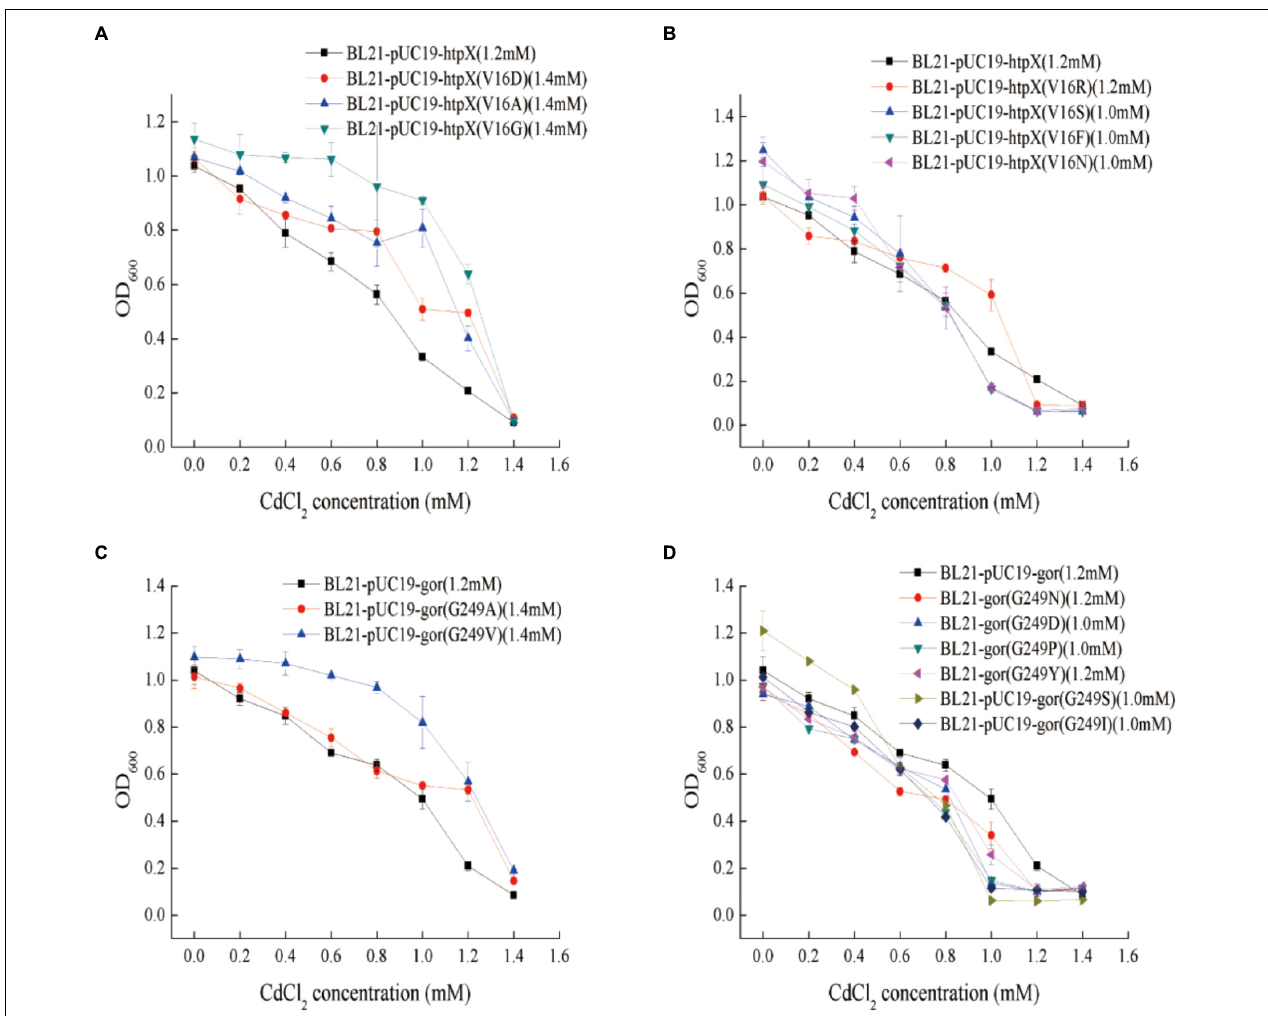
FIGURE 6 | Determination of the cadmium resistance of different mutant strains. (A,B) Cadmium resistance of htpX -overexpressing strains, with BL21-pUC19 as a negative control; in BL21-pUC19-htpX (V16A), the htpX gene was overexpressed, and the V16 residue of HtpX was mutated from Val (V) to Ala (A). (C,D) Cadmium resistance of gor -overexpressing strains; in BL21-pUC19-gor (G249A), the gor gene was overexpressed, and the G249 residue of Gor was mutated from G (Gly) to Ala (A). 1.0 and 1.2 mM represent the cadmium MIC